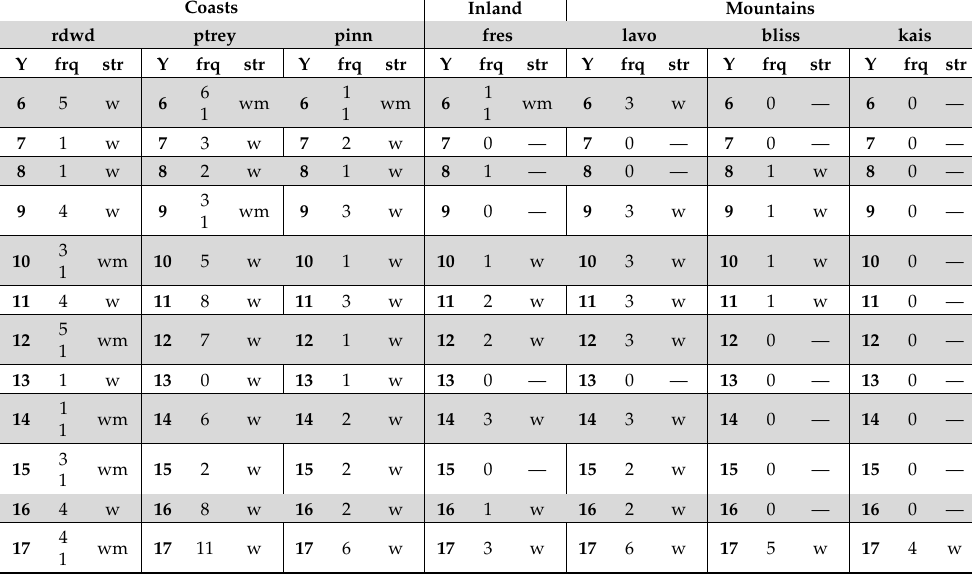
Table 1. January–April 2006–2017 AR Frequency and Strength. For each site and year (Y), AR frequency (frq) and strength (str) were determined based on (1) the number integrated water vapor transport (IVT) peaks above 250 kg m − 1 s − 1 for a given year as seen in Figure 7, which is the minimum IVT level for an AR event to be present, and (2) classifying strength based on the chart created by Ralph et al. (2019) [28]: Weak (250–500 m − 1 s − 1 ), moderate (500–750 m − 1 s − 1 ), strong (750–1000 m − 1 s − 1 ), extreme